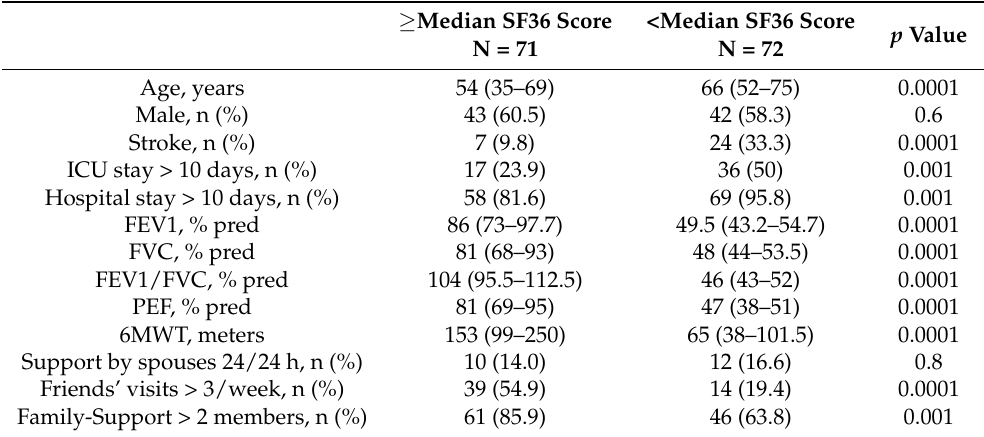
Table 3. Participant characteristics according to the median value of the physical domain of the SF36 questionnaire at 12 months.